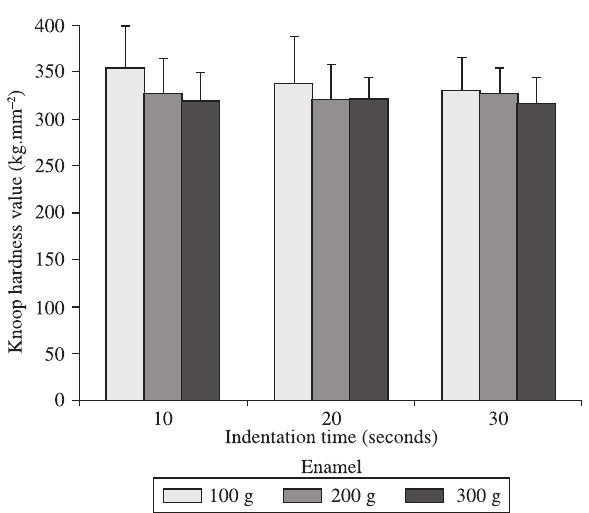
Figure 4. Average KHN values (SD) of dentin at different indentation loads and times.